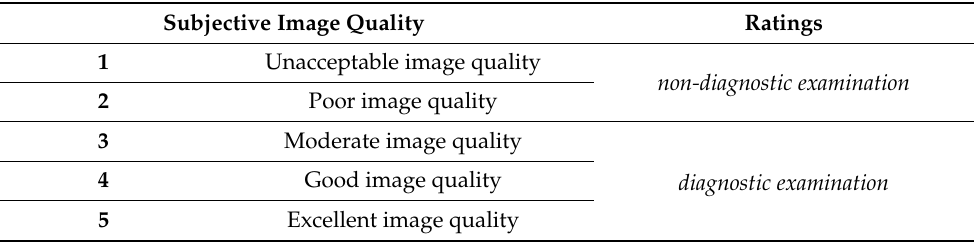
Table 2. Subjective image quality for ULD chest